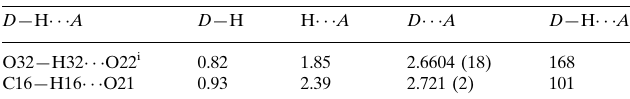
Hydrogen-bond geometry (A˚ , (cid:2)